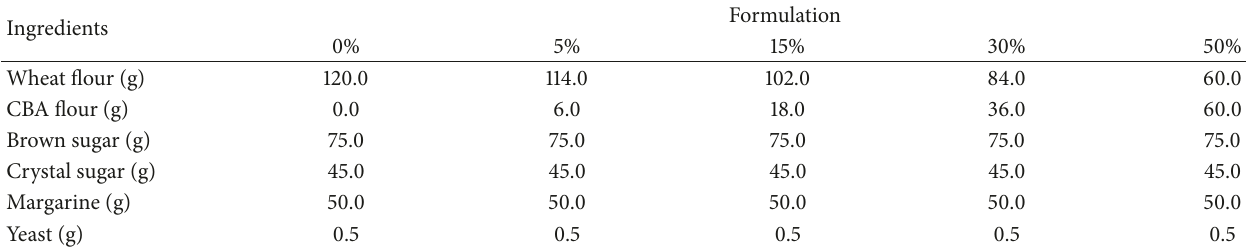
Table 1: Formulations used to prepare cookies.